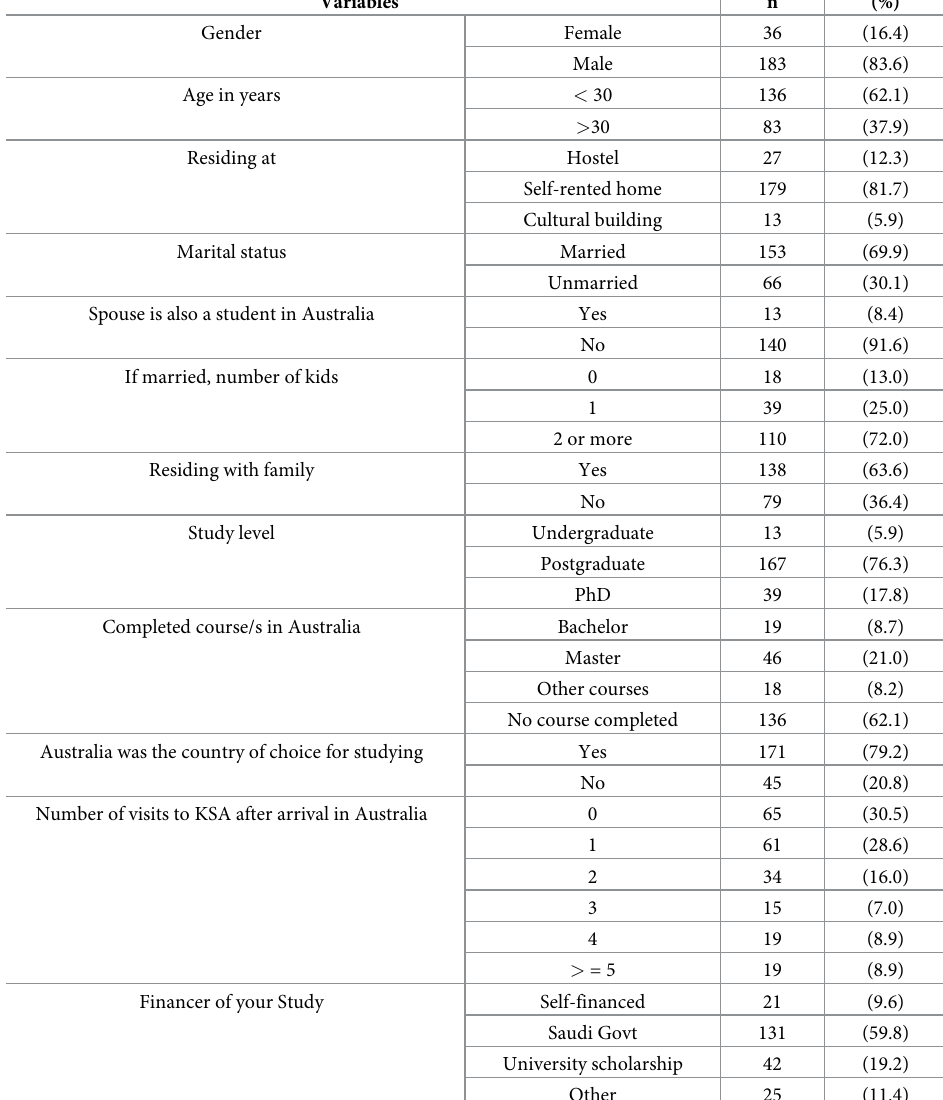
Table 1. General characteristics of study participants and their choice of study, number of visits to Saudi Arabia, and study financer.